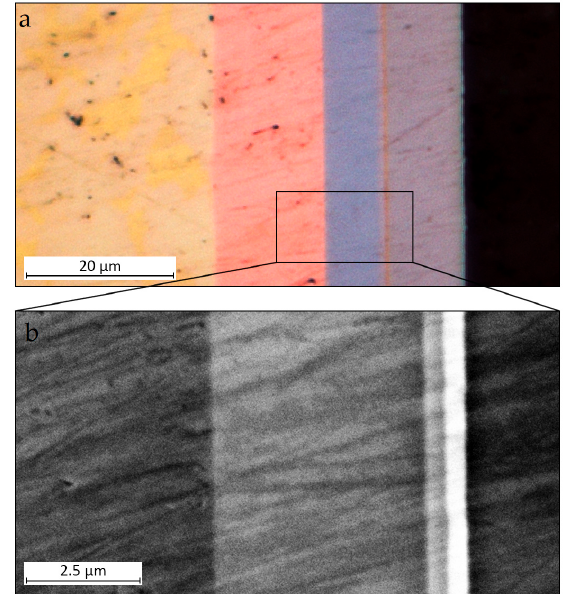
Figure 1. Cross-section multilayer sample (brass / Cu / bronze / Pd / Au / Ni) observed with an optical microscope ( a ) and electron microscope ( b ).